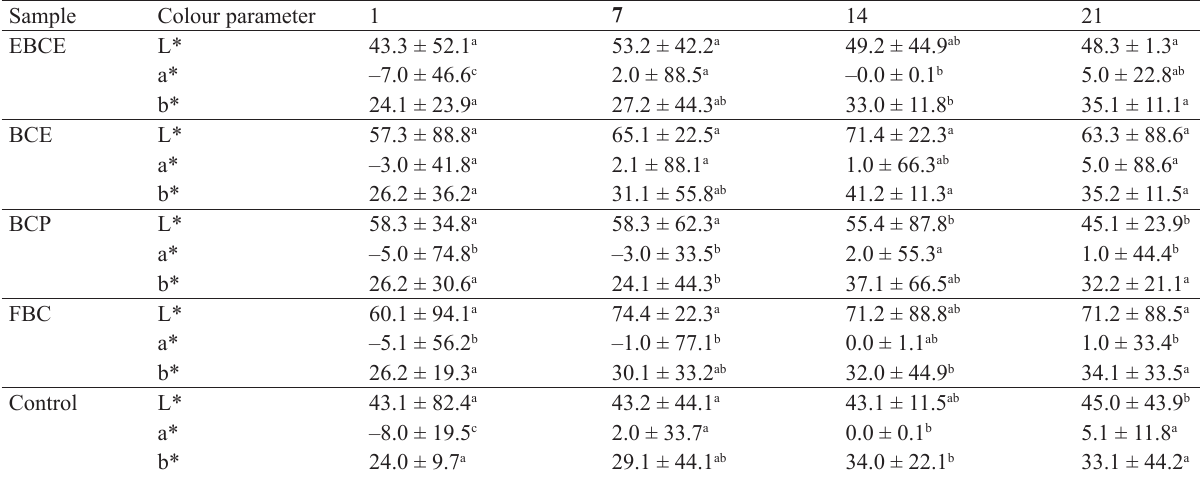
Table 3 Colour characteristics of kolompeh samples on day 1, 7, 14, and 21 of storage Sample